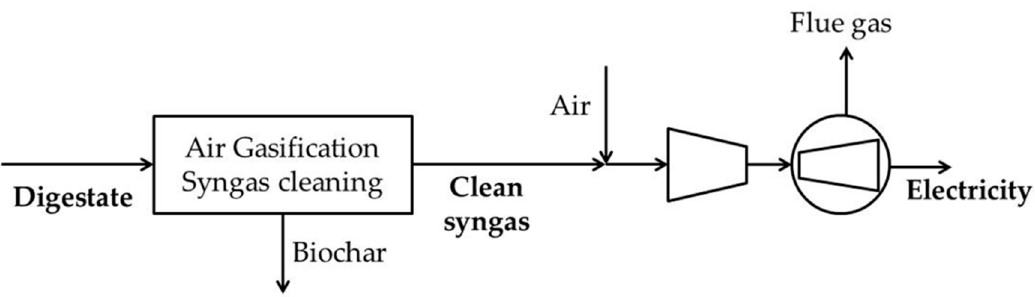
Figure 2. Flowsheet of valorization of anaerobic digestate for producing of electrical power.